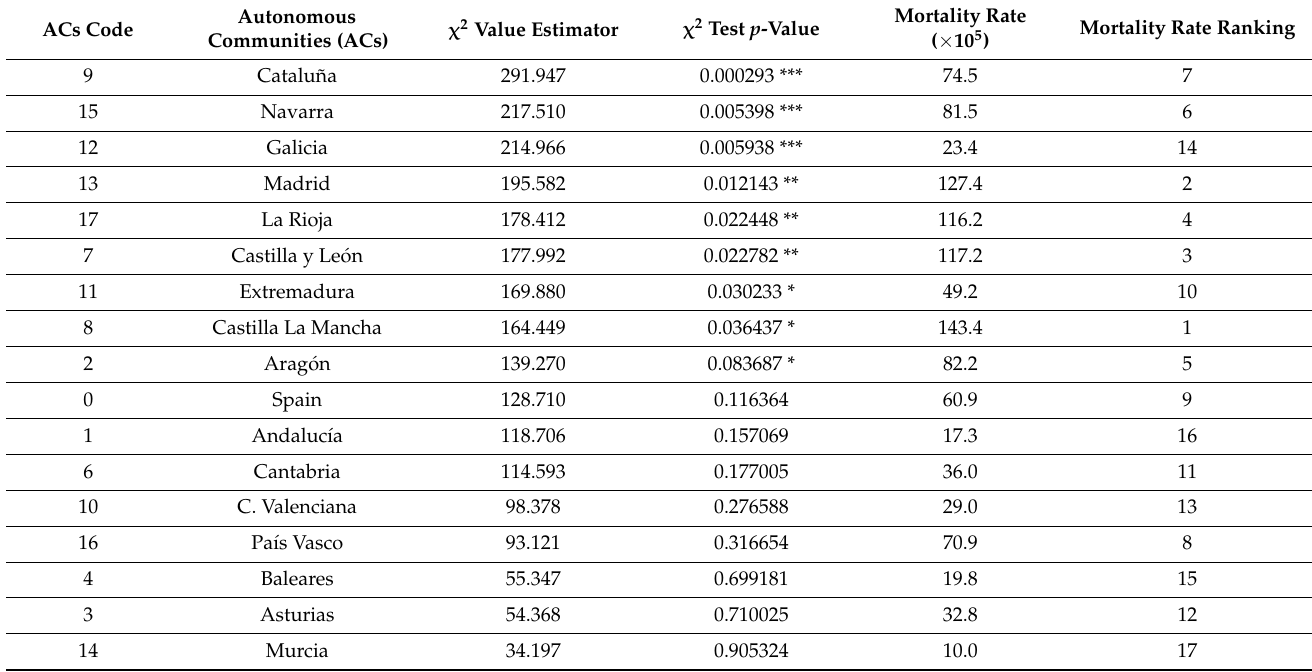
Table 2. Regions ranked by χ 2